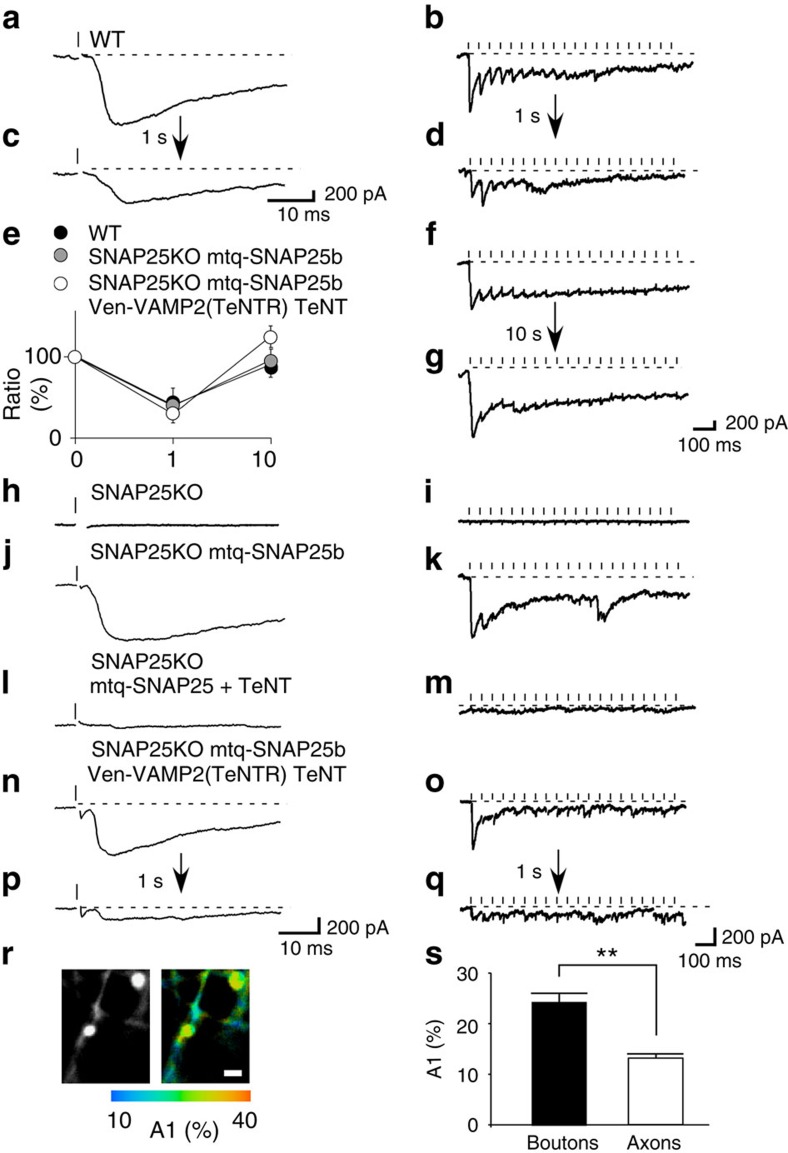
Kinetics of EPSCs, depletion and refilling of vesicles mediated by mtq-SNAP25b/Ven-VAMP2 in SNAP25 KO mice treated with TeNT.(a,b) EPSCs recorded from dissociated cultures from wild-type (WT) mice after the first stimulation (a) and during 20 repetitive stimuli at 20 Hz in the presence of picrotoxin (50 μM) and cyclothiazide (100 μM). The current traces were recorded with whole-cell patch clamp, and presynaptic fibres were stimulated with a glass electrode. (c,d) EPSCs evoked from the same cell by the second repetitive stimulation 1 s after the first train of stimuli. (e) Amplitudes of the first EPSCs in the repetitive stimulation relative to that of the first train of stimulation. Two trains were separated by 1 s in the preparations from WT mice (filled circles, 40±21%, n=6, P=0.04), those from the KO mice rescued with mtq-SNAP25b (grey circles, 29±8.5%, n=5, P=0.043), and those from the KO mice expressing mtq-SNAP25b and Ven-VAMP2 (TeNT resistant) after treatment with TeNT (open circles, 39±12%, n=8, P=0.01). The P values were obtained with the Wilcoxon signed-rank test. The amplitudes recovered to 91±16% (n=6, P=0.6), 96±13% (n=4, P=0.1), and 125±13% (n=4, P=0.9) when the interval was set to 10 s. (f,g) EPSCs evoked by the first (f) and second (g) repetitive stimulation separated by 10 s. (h–m) EPSCs recorded from dissociated cultures obtained from SNAP25 KO mice (h,i), those rescued by mtq-SNAP25b (j,k) and those with exocytosis blocked by TeNT treatment (l,m). (n–q) Current traces recorded from dissociated culture preparations from SNAP25 KO mice expressing mtq-SNAP25 and Ven-VAMP2(TeNTR), and treated with TeNT for 1 day. The first and second repetitive stimuli were separated by 1 s. (r) Fluorescence and A1 images of mtq-SNAP25b/Ven-VAMP2(TeNTR)-expressing boutons (scale bar, 1 μm). (s) The mean A1 values in boutons (24.4±1.6%, n=23) and axons (13.1±0.7%, n=35). A Mann–Whitney U-test yielded a **P value of 0.0000. The average expression levels of mtq-SNAP25 and Ven-VAMP2(TeNTR) were 79±6.7 a.u. and 541±39 a.u., respectively.